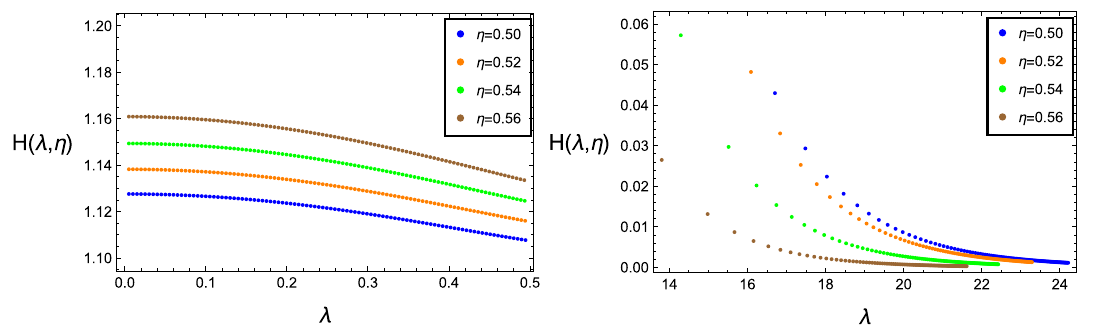
the parameters, M = 1, q = 0 . 1, Q m = 0 . 1, and (cid:9) AdS = 1, for the convenience of numerical calculations and